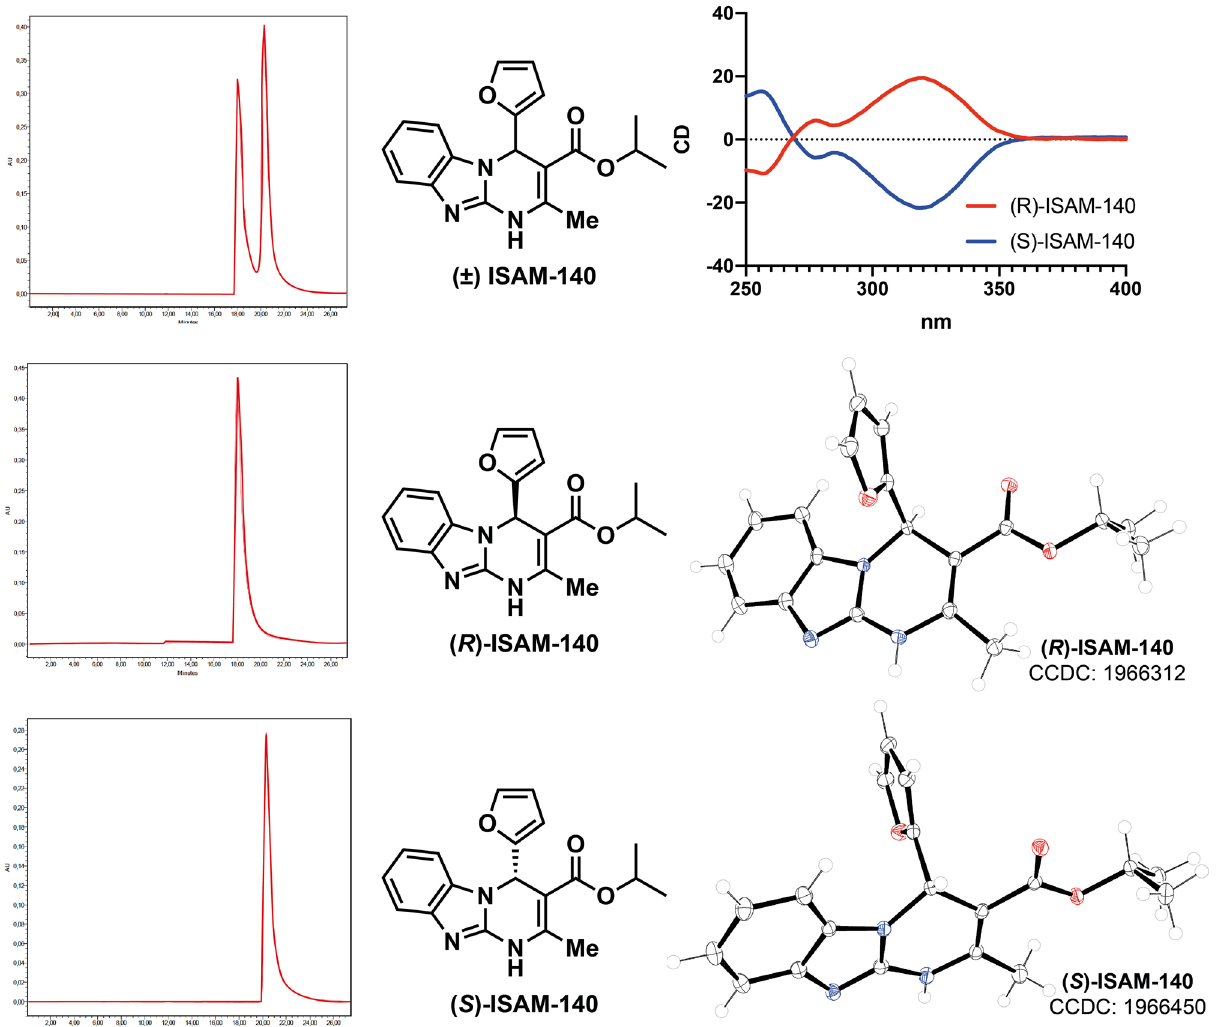
Figure 3. Chiral HPLC separation, circular dichroism spectra and crystal X-ray structure of compounds (R) - ISAM-140 and (S) -ISAM-140.